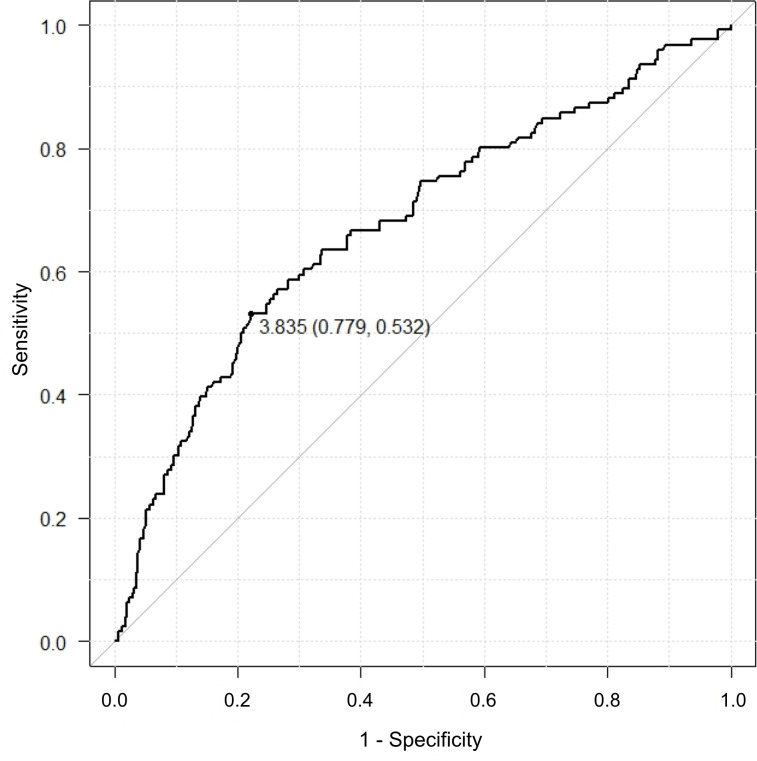
Receiver operating characteristic curve (ROC) for left ventricular hypertrophy on electrocardiogram by the Sokolow-Lyon voltage criteria.The cut-off value is 3.835, specificity is 0.779, and sensitivity is 0.532.